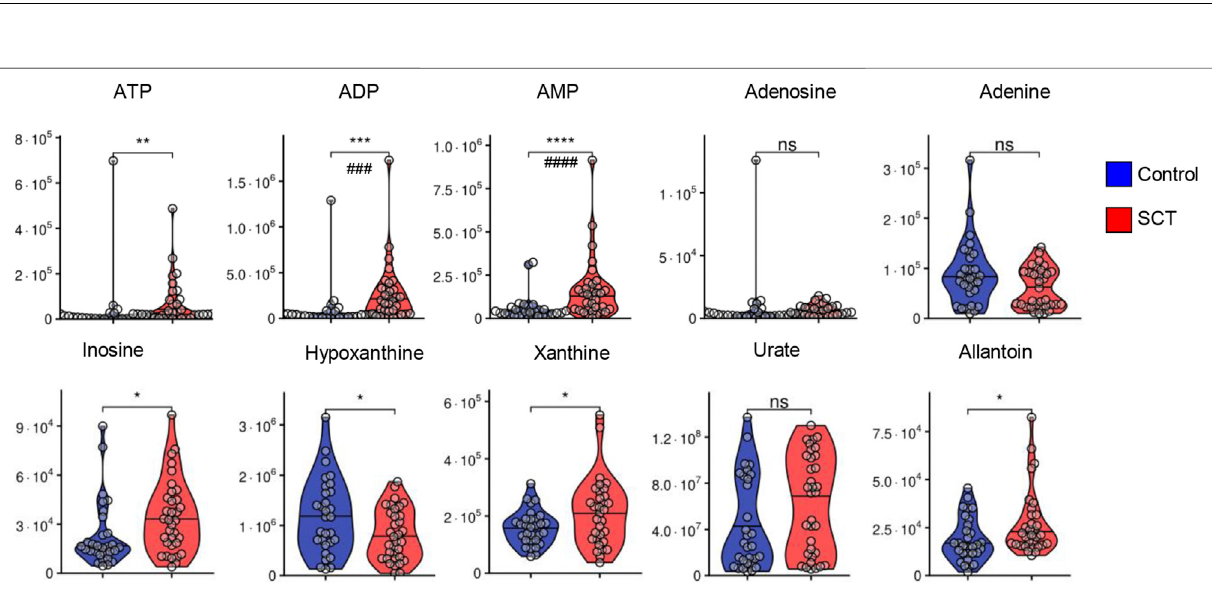
Frontiers in Physiology |